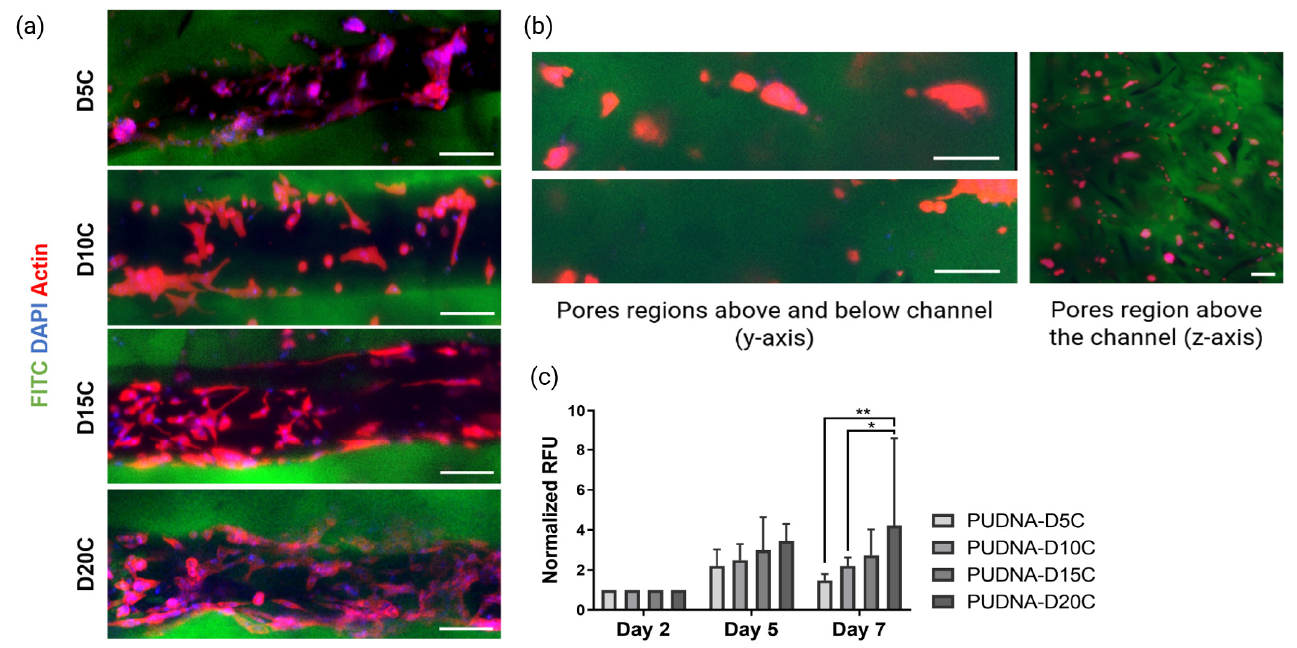
Figure 4. Cell analysis of seeded HUVECs on coated, cationized hydrogels with increasing DD concentrations: ( a ) Images represent Z-Projection, average intensity, showing cell morphology at day 7 via CLSM. Scale bar = 100 µ m; ( b ) Representative image (Z-Projection) of cells in the pore region outside the channel on coated scaffold. Scale bar = 100 µ m; ( c ) Cell metabolic activity determined by resazurin assay on days 2, 5, and 7. All resofurin fluorescence unit (RFU) values of each condition were normalized to their own RFU value on day 2. Statistical analysis was performed using a two-way ANOVA with multiple comparisons. * p < 0.05, ** p < 0.01.